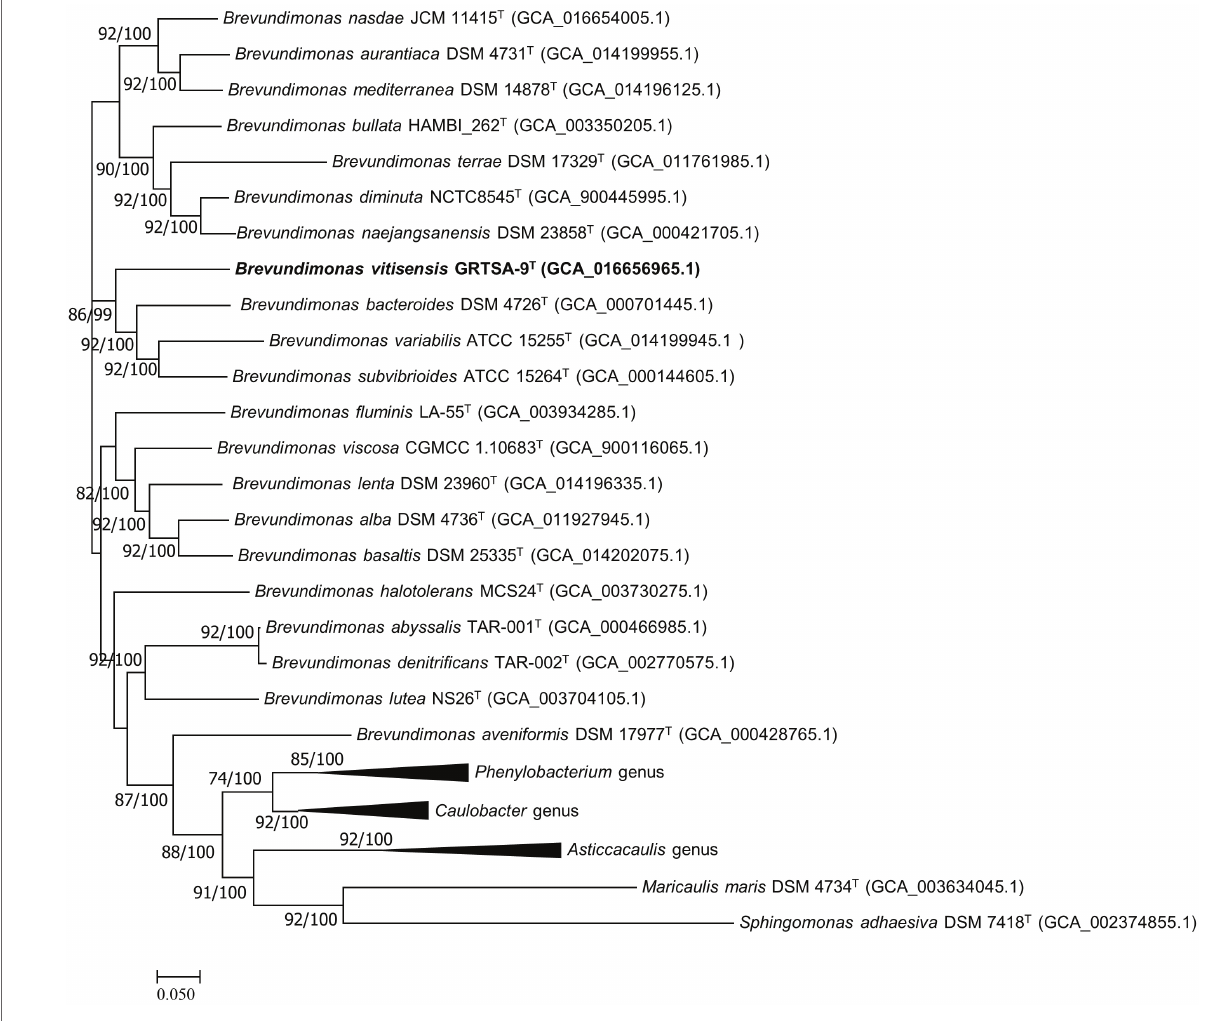
FIGURE 2 | Maximum likelihood algorithm phylogenomic tree based on up-to-date bacterial core gene set (concatenated alignment of 92 core genes) showing the relationship between strain GR-TSA-9 T and the members of the family Caulobacteraceae . Gene support index (GSI, left) and bootstrap values (right) are indicated at the nodes. Scale bar: 0.050 substitutions per